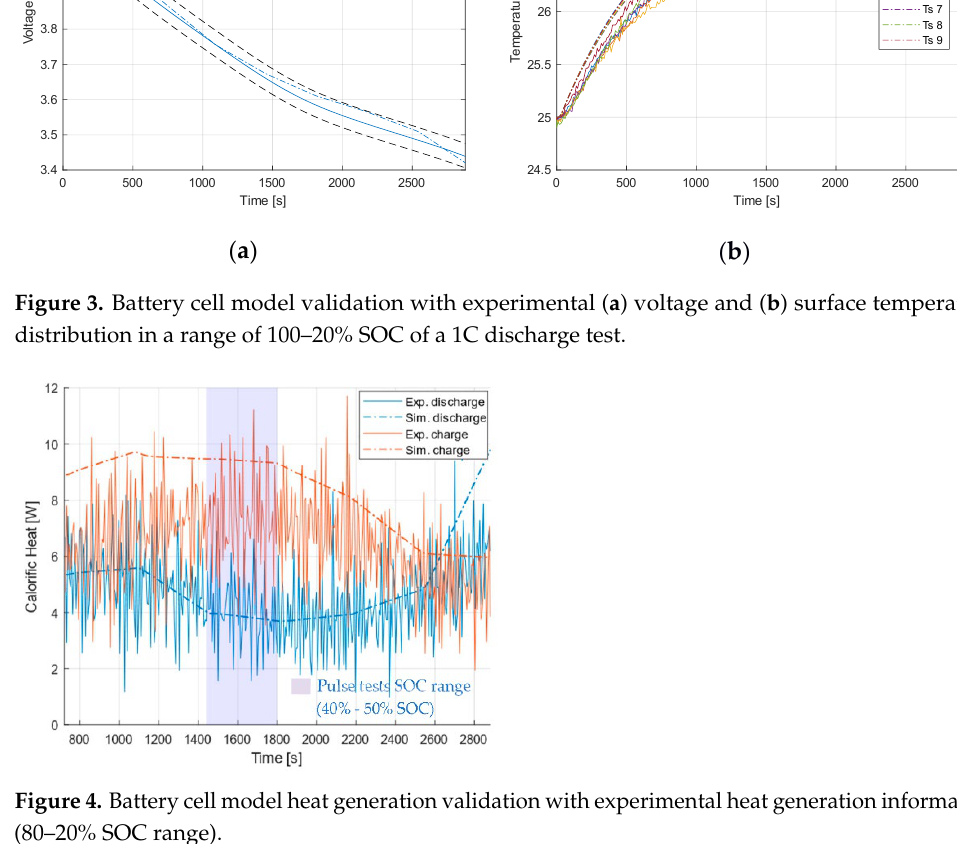
Figure 4. Battery cell model heat generation validation with experimental heat generation infor- mation (80–20% SOC range).